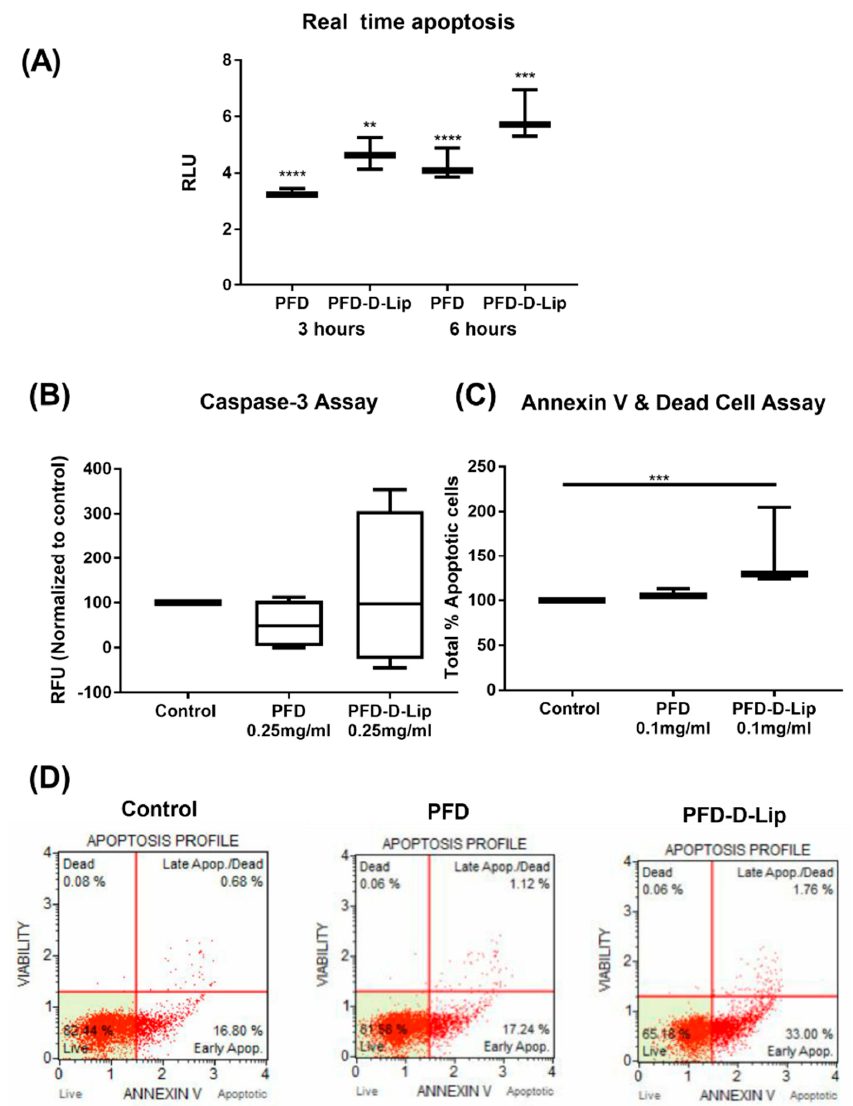
Figure 11. Effects of PFD-loaded liposomes on apoptotic events in A549 cell line. ( A ) Repeated measures of luminescence during exposure to different treatments. A549 cells were exposed to control, PFD, PFD–D-Lip in the presence of the Real Time-Glo™ Annexin V Apoptosis and Necrosis Assay Reagent. Plates were incubated 37 ◦ C / 5% CO 2 . RLU were collected at 0, 3, 6, 12 h. Data represent the mean of 3 readings for each treatment ± SEM. Significance between different time points for each treatment groups were analyzed by one-way ANOVA and Tukey’s multiple comparison test. ( B ) Detection of caspase-3 levels in A549 cells using the EnzChek ® Caspase-3 Assay. Cells were treated with either 0.25mg/ml PFD or PFD–D-Lip, and were incubated for 6 hours at 37 °C. Cells were harvested, lysed and assayed. Reactions were carried out at room temperature, and fluorescence was measured in a fluorescence microplate reader using excitation at 360 nm with emission detection at 460 nm after 20 min. Results indicate relative fluorescence units (RFU) normalized to control after each treatment. Data represent the mean of 3 readings for each treatment ± SEM. Significance between the groups was analyzed by one-way ANOVA and Tukey’s multiple comparison test. ( C ) Total % apoptotic profile: graph representing total % of apoptosis when treated with PFD and PFD–D-Lip relative to control. ( D ) Apoptotic impacts of multiple compounds on A549 cell line. Untreated A549 cells were compared with cells treated with PFD and PFD–D-Lip for 24 h using the Muse ™ Annexin V & Dead Cell Assay. ** p ( α < 0.01), *** p ( α < 0.001), **** p ( α <